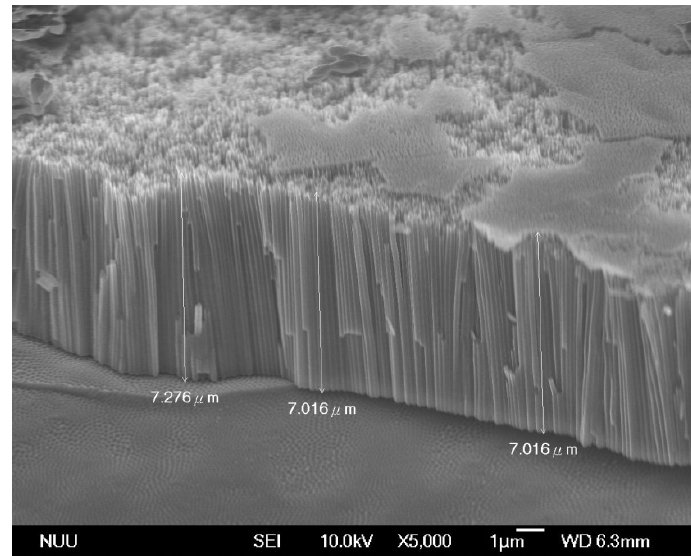
Figure 5. A FE-SEM cross-sectional image of titania nanotubes made by anodization grown at 60 V in an ethylene glycol solution for 1